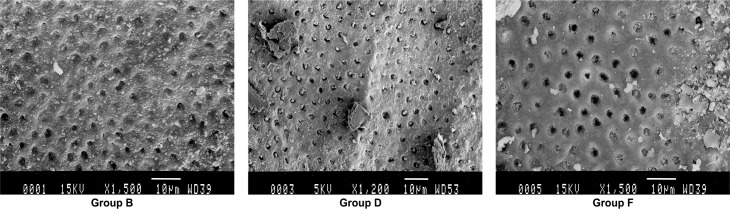
Scanning electron micrographs of the root canals of each group (× 1500).